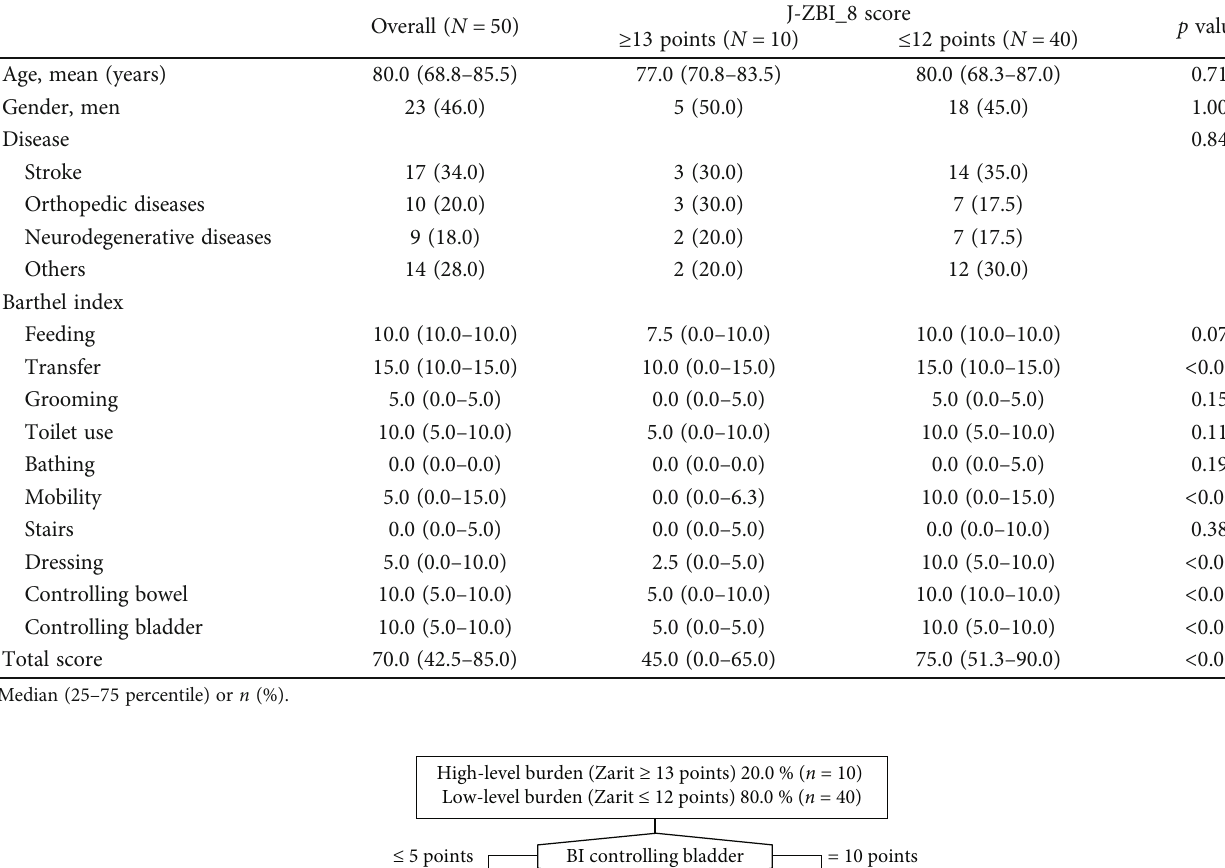
Table 1: Characteristics and level of independence in activities of daily living by groups.